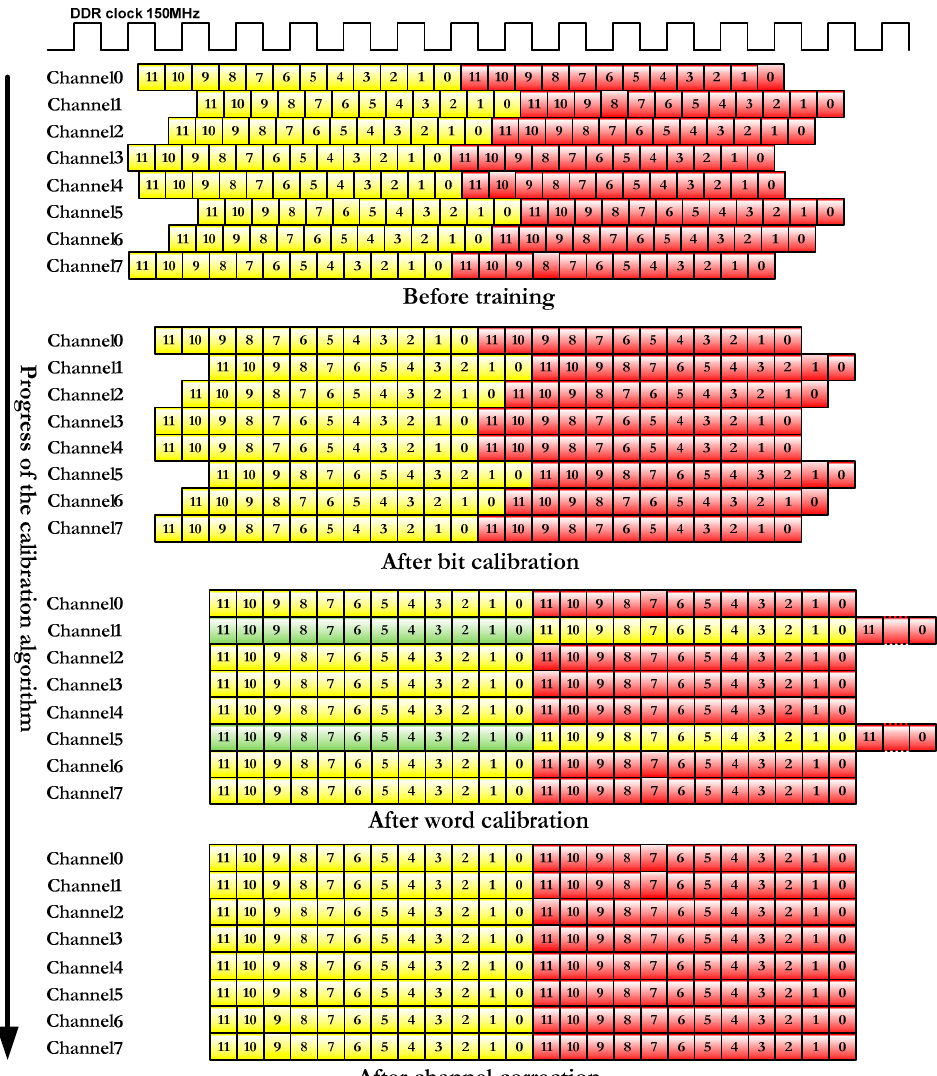
Figure 6. Calibration process.